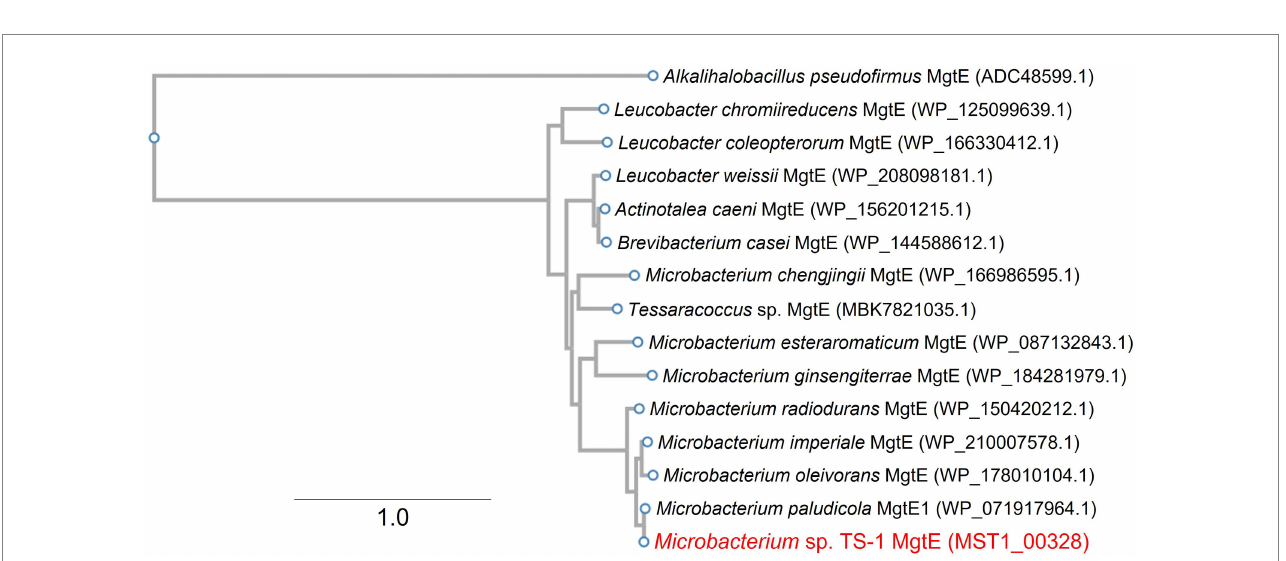
Table summarizes the proteins encoded by the genes confirmed to be mutated in the Cs + -sensitive mutants and reverted in the Cs + -resistant revertants. For genes with mutations and nonsynonymous amino acid substitutions, the mutations are shown in parentheses in the following order: wild type, Cs + -sensitive mutant, and Cs + -resistant revertant.